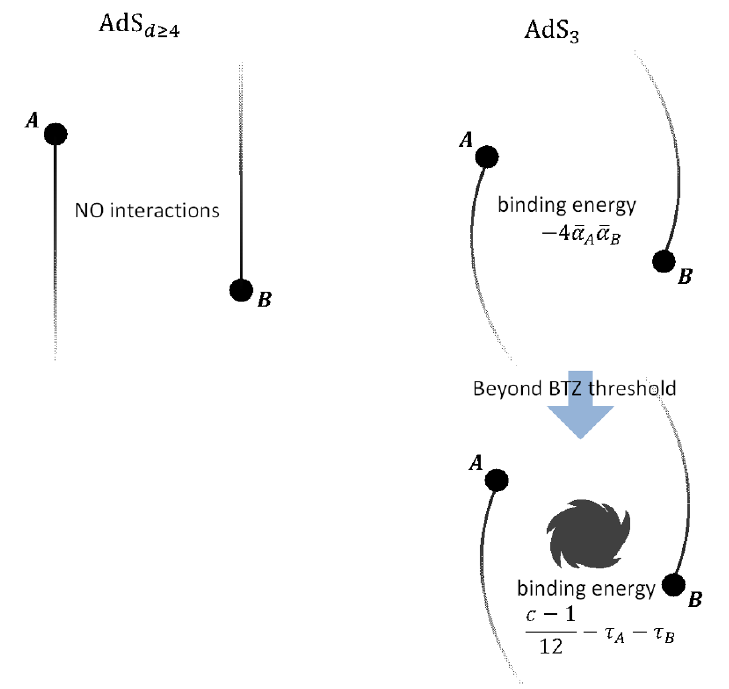
Figure 2 . This (cid:12)gure shows the implications of the light cone bootstrap on the nature of AdS. In AdS d (cid:21) 4 , the interactions between two objects become negligible at large angular momentum. On the other hand, in AdS 3 , there exists a universal binding energy (cid:0) 4(cid:22) (cid:11) A (cid:22) (cid:11) B even at large angular momentum. If the total Liouville momentum is above the BTZ threshold (cid:11) BTZ , the binding energy is given by c (cid:0) 1 (cid:0) (cid:28) A (cid:0) (cid:28) B 12